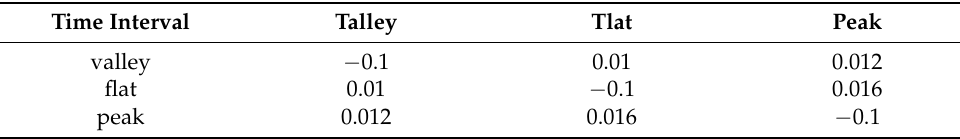
Table 2. Electricity price demand elasticity matrix coefficient.